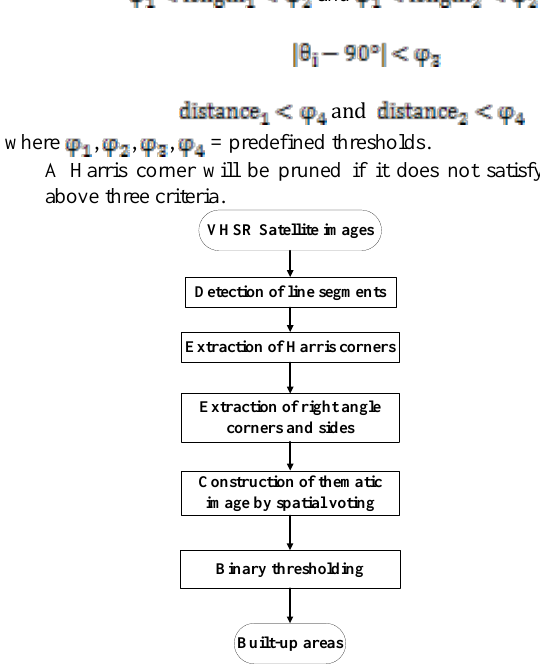
Figure 1. Flow chart of the proposed method